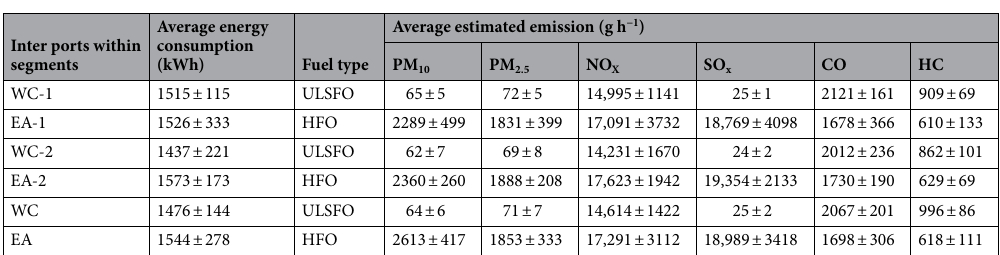
Table 2. Average energy consumption and emission of the six air pollutants from the auxiliary engine while inter ports within the West Coast and East Asia segments.